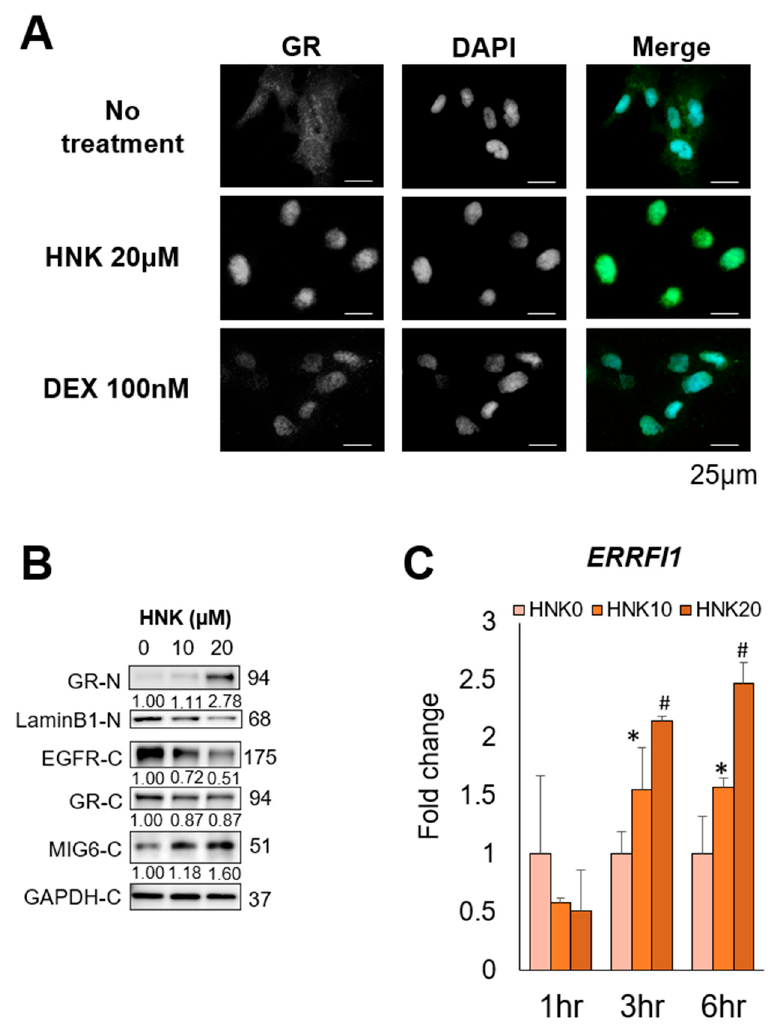
Figure 5. Honokiol (HNK) induces glucocorticoid receptor (GR) nuclear translocation, leading to mitogen-inducible gene 6 (MIG6) induction in Hep3B cells. ( A ) Subcellular localization of GR in Hep3B cells 2 h after incubation with the vehicle, 20 µ M HNK, or 100 nM dexamethasone (DEX) was examined via immunofluorescence staining. 4 ′ ,6-Diamidino-2-phenylindole (DAPI) was used for nuclear counterstaining. ( B ) Immunoblot analysis of nuclear (-N) and cytoplasmic (-C) extracts from Hep3B cells 9 h after incubation with 0, 10, or 20 μ M HNK. Protein expression of GR, epider- mal growth factor receptor (EGFR), and MIG6 was examined. Lamin B1 (nuclear) and GAPDH (cytoplasmic) were used as loading controls. ( C ) Relative expression of ERRFI1 mRNA in Hep3B cells treated with the indicated concentrations of HNK. All graphs represent the mean ± SD (* p < 0.05, # p < 0.01 vs. HNK0 condition at the same time course).